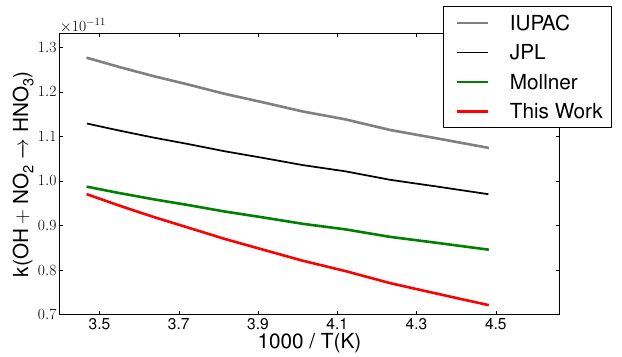
q Fig. 5. Evaluated NO 2 + HO rate coefficients from IUPAC04 (IU- Fig. 5. Evaluated NO 2 + HO . rate coefficients from IUPAC04 (IUPAC), JPL11 (JPL), Mollner et al. (2010) PAC), JPL11 (JPL), Mollner et al. (2010) (Mollner), and this work (Mollner), and this work for temperatures and pressures from the US standard atmosphere 1976. for temperatures and pressures from the US standard atmosphere